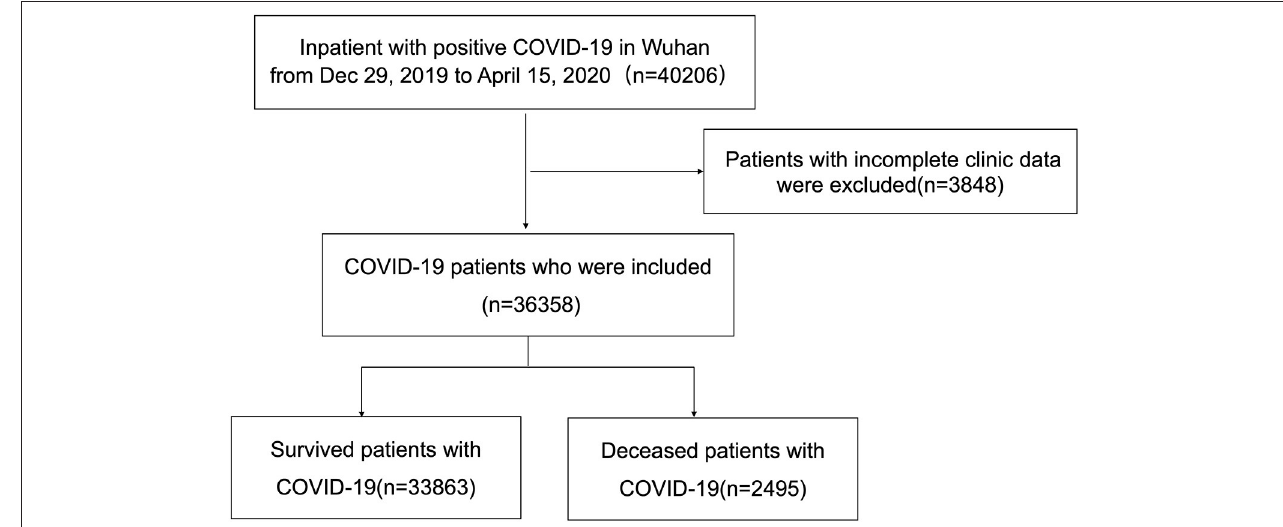
FIGURE 1 | Flowchart of patient inclusion and exclusion.